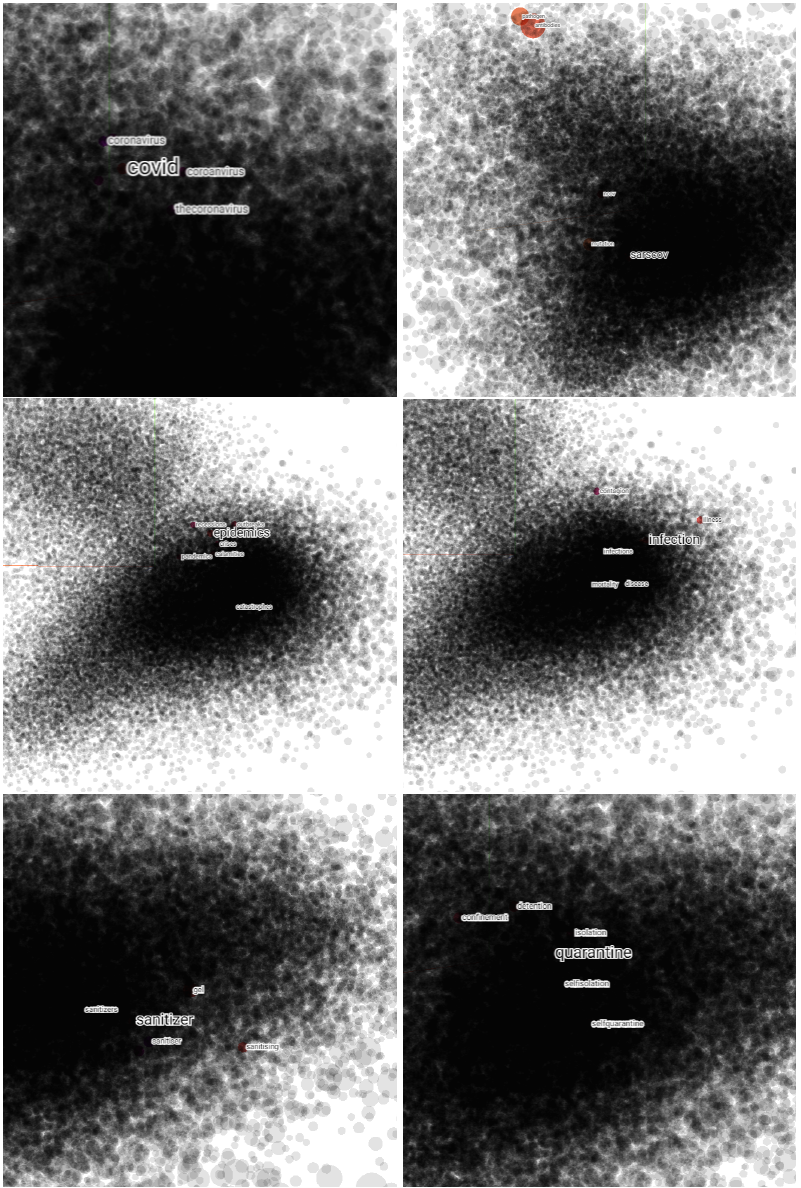
Figure 2. Word embeddings, obtained with doc2vec, projected onto a 3D subspace with principal component analysis (PCA). In each figure there is a word that is connected to the coronavirus and its closest neighbors, where the proximity measure is cosine